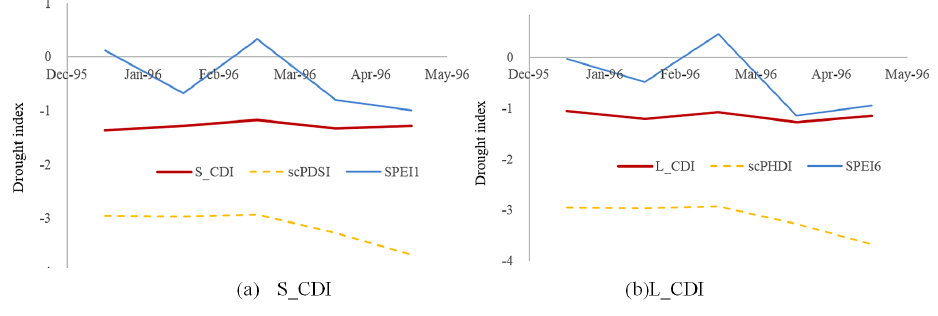
Figure 4. The 1996 drought.